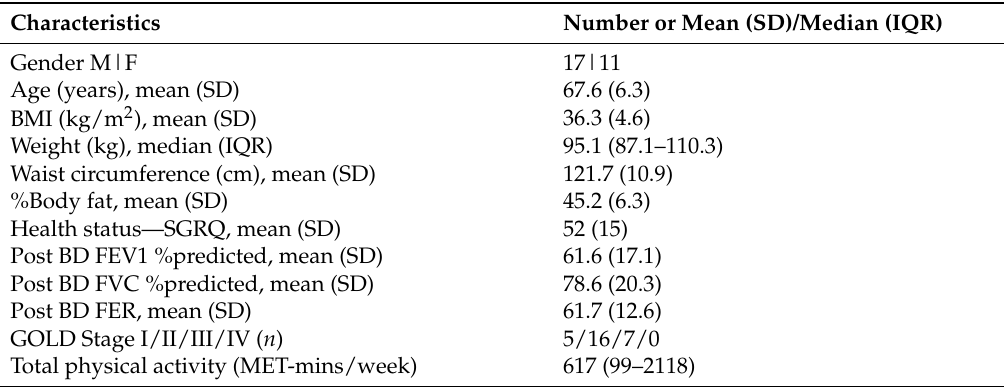
Table 1. Subject characteristics at baseline ( n =